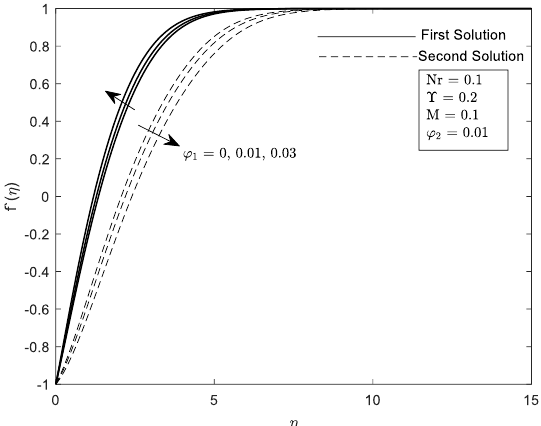
Figure 25. 𝑓 ′ (𝜂) on different nanoparticles 𝜑 1 .